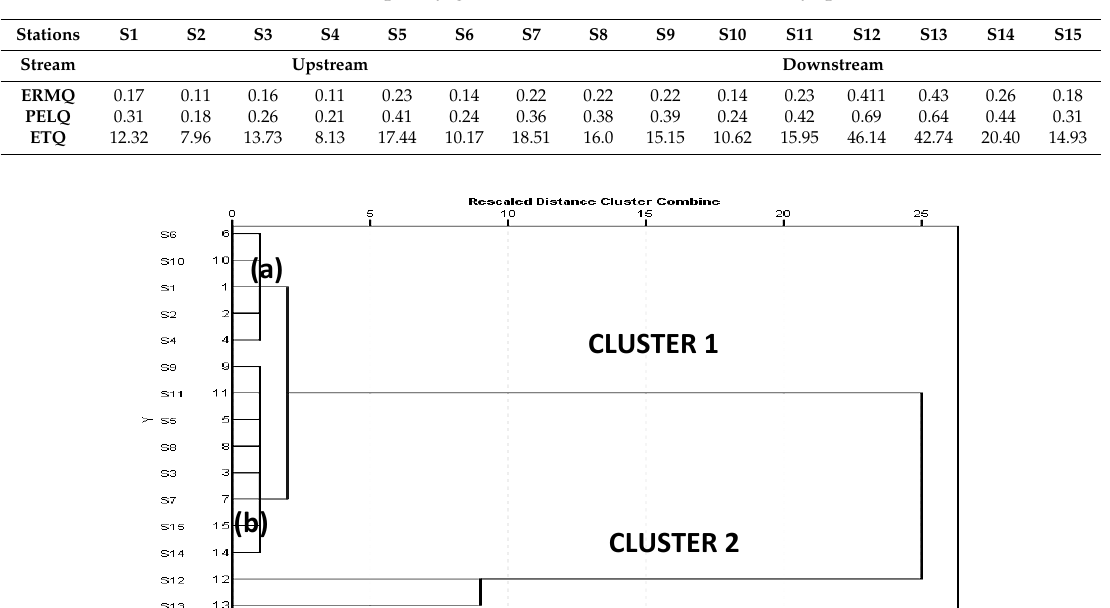
Table 3. Metal ‐ to ‐ metal correlation coefficient matrix for metals in sediment samples.